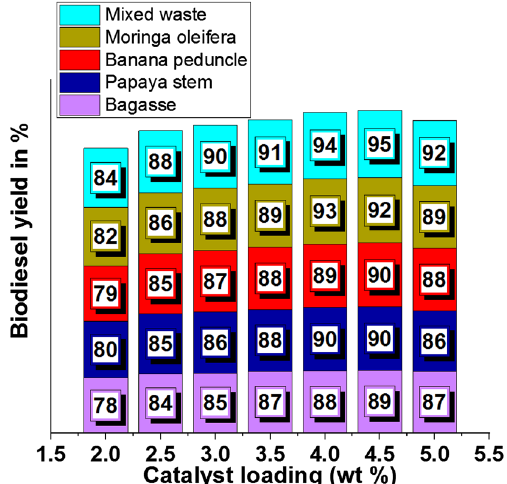
Figure 9. Comparison of biodiesel yield with different plant waste (Catalyst loading).